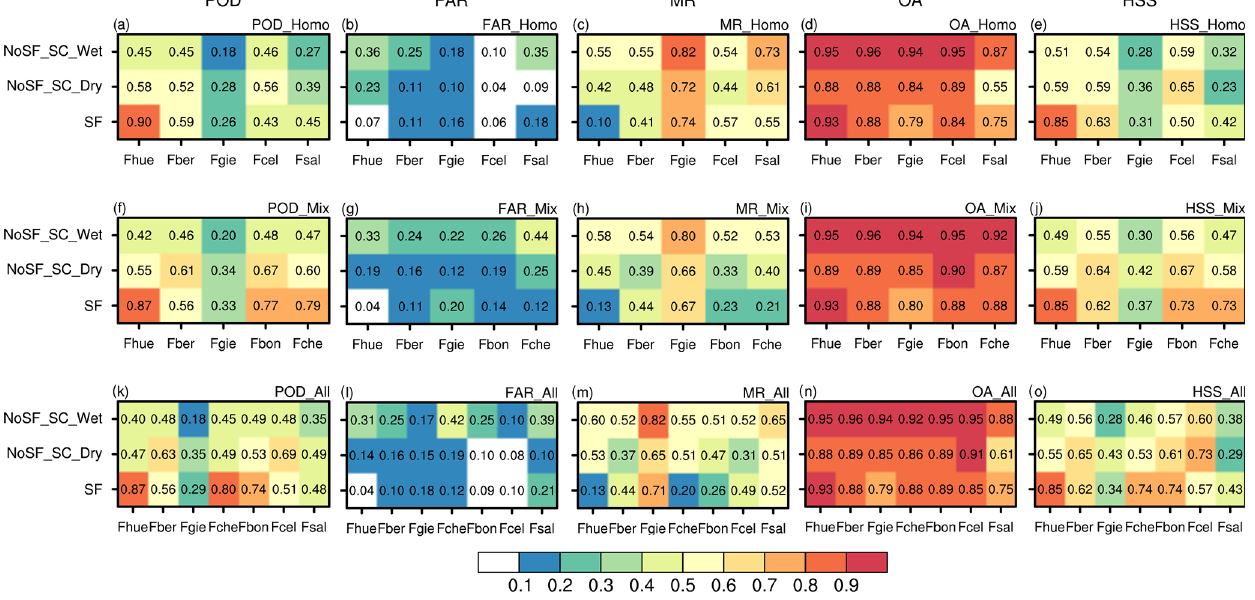
indices; improvement was also noted in the MR.